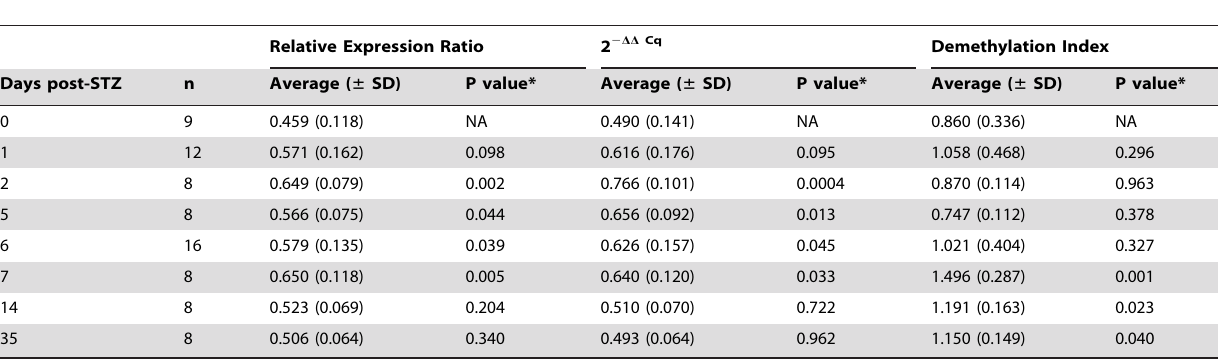
Table 4. Comparison of the average and standard deviation of three methods of quantification of unmethylated DNA levels using qMSP.